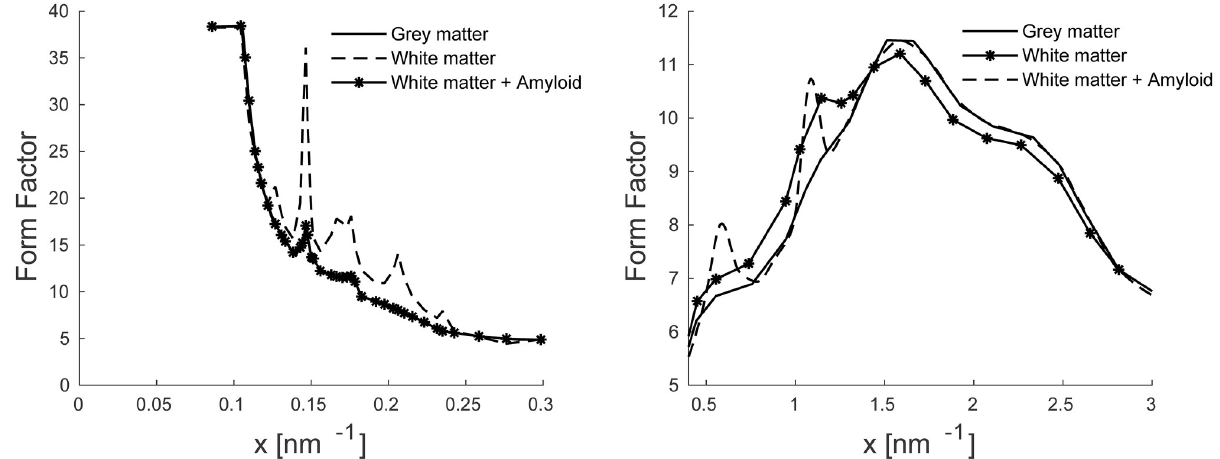
Fig 2. Coherent scattering form factor for grey, white and white plus β A materials used in the